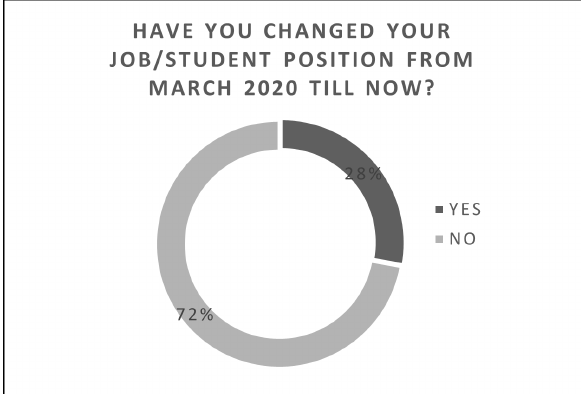
Figure 4: Circle chart of new job positions.